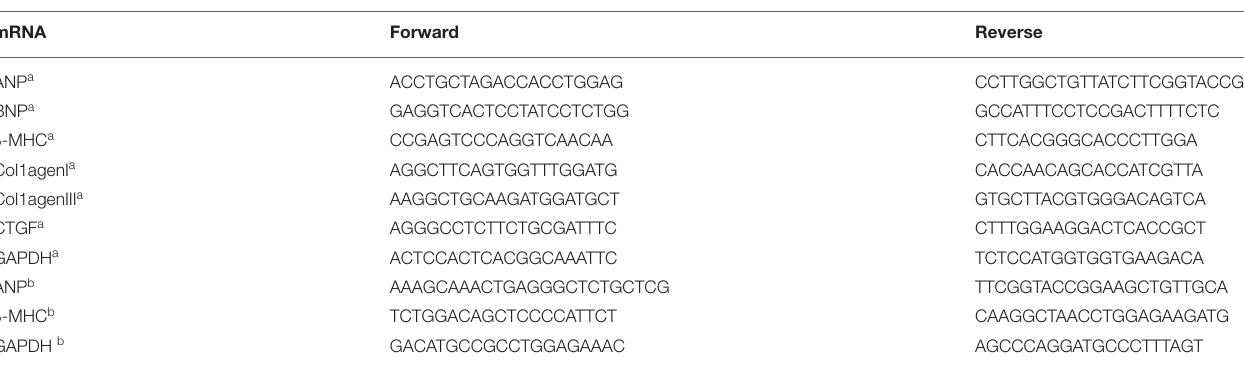
TABLE 1 | Primer sequences used for